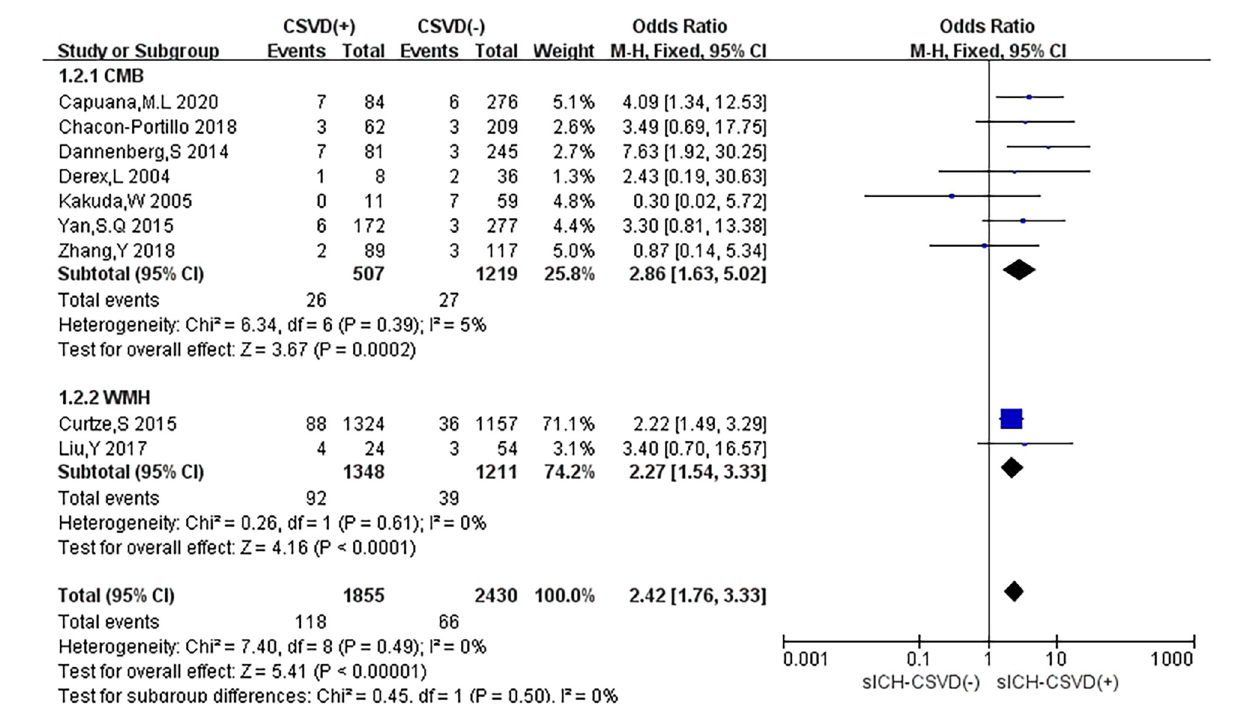
FIGURE 6 | Forest plot of subgroup analysis showing the impact of subtypes of CSVD on sICH.